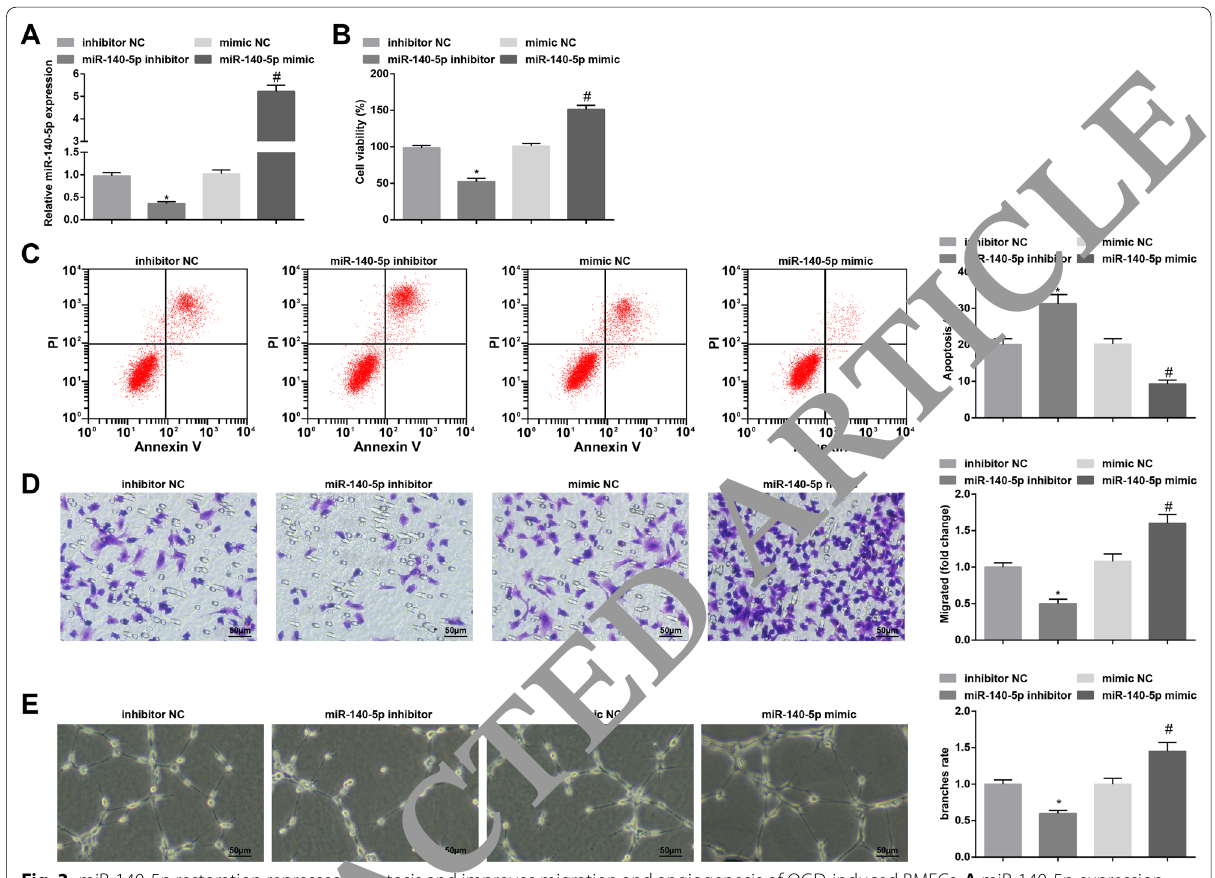
Fig. 3 miR-140-5p restoration represses apoptosis and improves migration and angiogenesis of OGD-induced BMECs. A miR-140-5p expression in miR-140-5p inhibitor- or miR-140-5p mimic-transfected and OGD-induced BMECs detected by RT-qPCR; B Viability of miR-140-5p inhibitor- or miR-140-5p mimic-transfected and OGD-induced BMECs detected by MTT assay; C Cell apoptosis of miR-140-5p inhibitor- or miR-140-5p mimic-transfected and OGD-induced BMECs detected by flow cytometry; D Cell migration ability of miR-140-5p inhibitor- or miR-140-5p mimic-transfected and OGD-induced BMECs detected by Transwell assay; E Angiogenesis of miR-140-5p inhibitor- or miR-140-5p mimic-transfected and OGD-induced BMECs detected by Matrigel method; N 3; * P < 0.05 compared with the inhibitor NC group; # P < 0.05 compared with the mimic = NC group. The data were expressed as mean standard ±